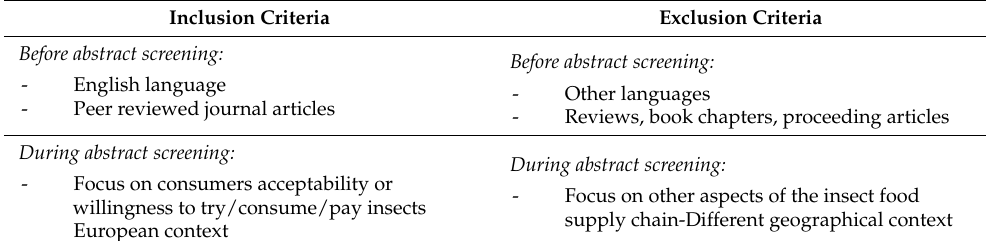
Table 2. Eligibility